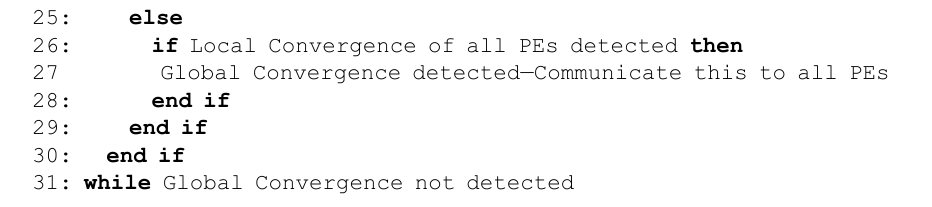
PLOS ONE | https://doi.org/10.1371/journal.pone.0277940 November22,